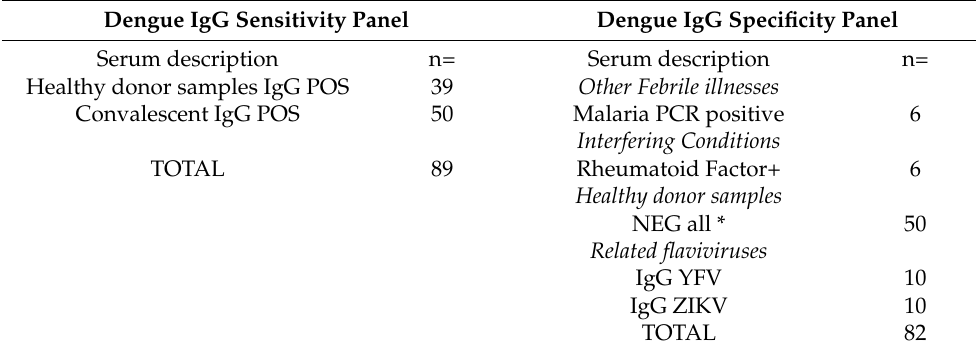
Table 3. Dengue IgG sensitivity and specificity panel.